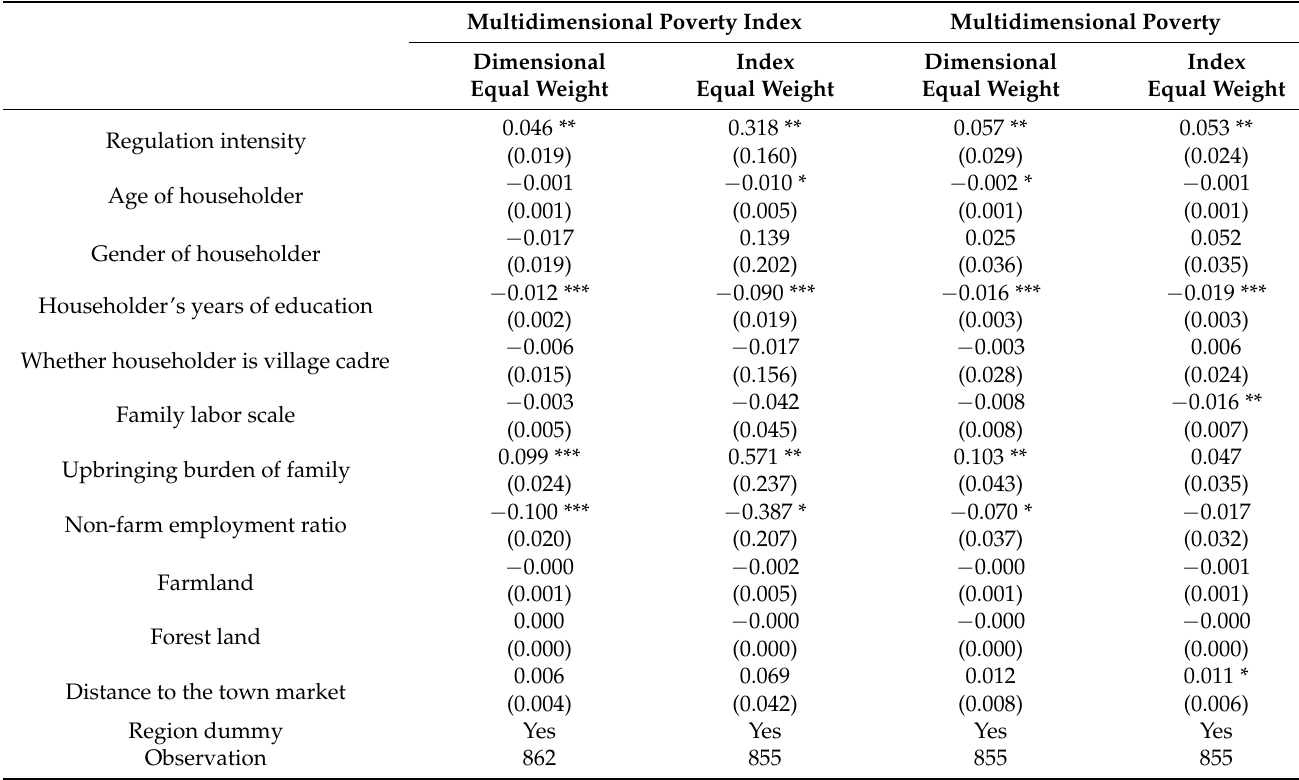
Table 8. Robust check 2: using new independent variable ( k = 3).